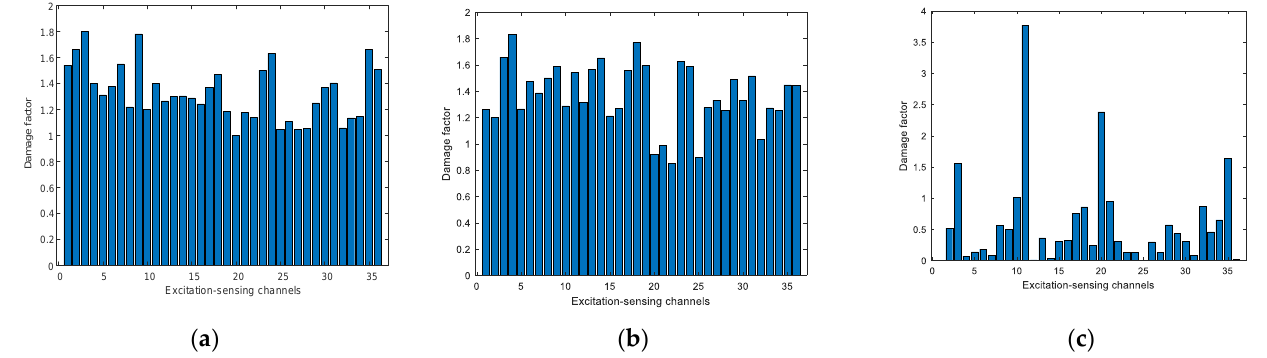
Figure 10. Results of different damage factors at 90,000 fatigue cycles: ( a ) energy damage factor; ( b ) cross-correlation damage factor; ( c ) sparse representation damage factor.